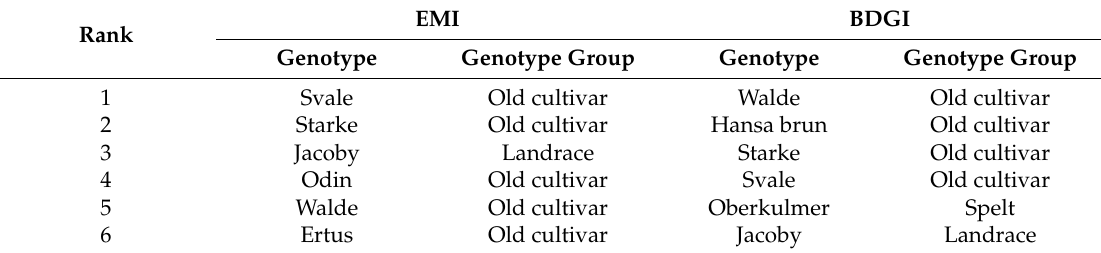
Table 7. Rankings of the winter wheat genotypes with the highest Elston multiplicative selection index (EMI) and Baker’s desired gains index (BDGI). The genotype group to which each genotype belongs is also